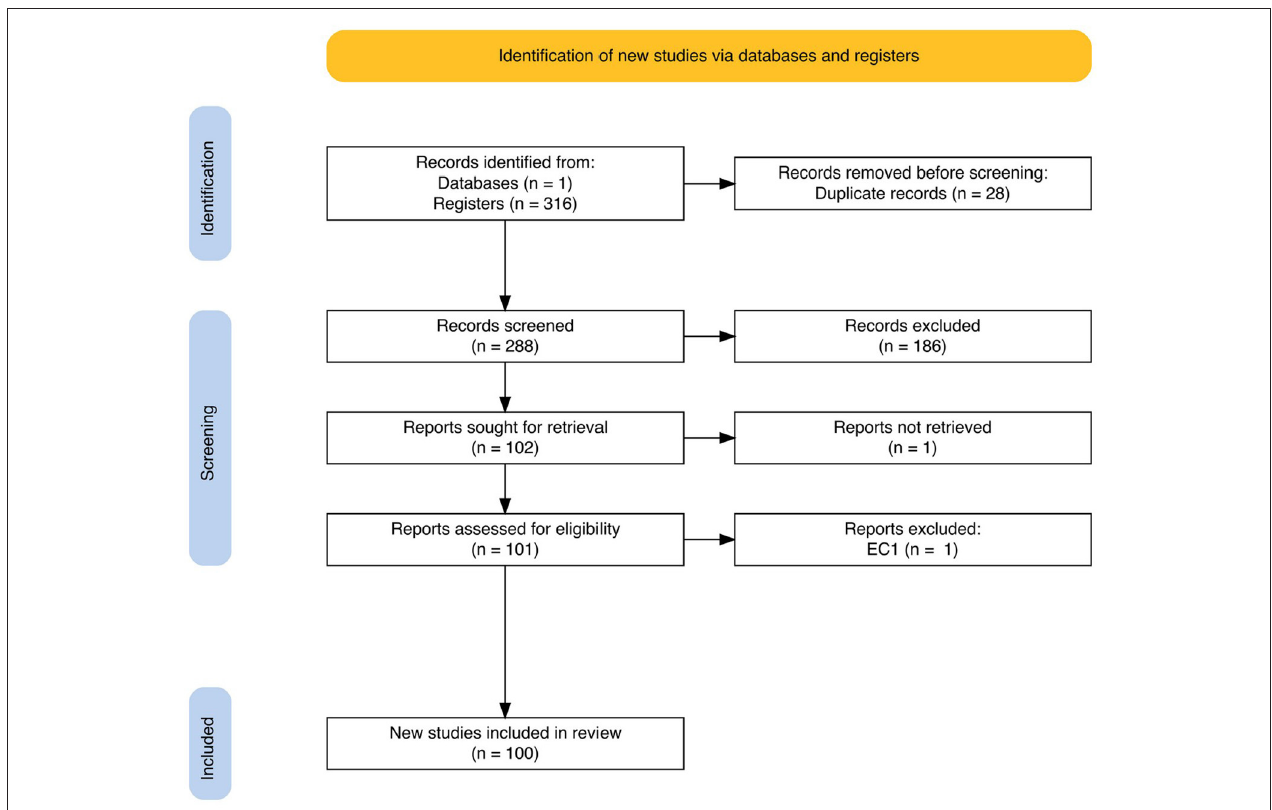
FIGURE 1 | Flow chart of the study selection